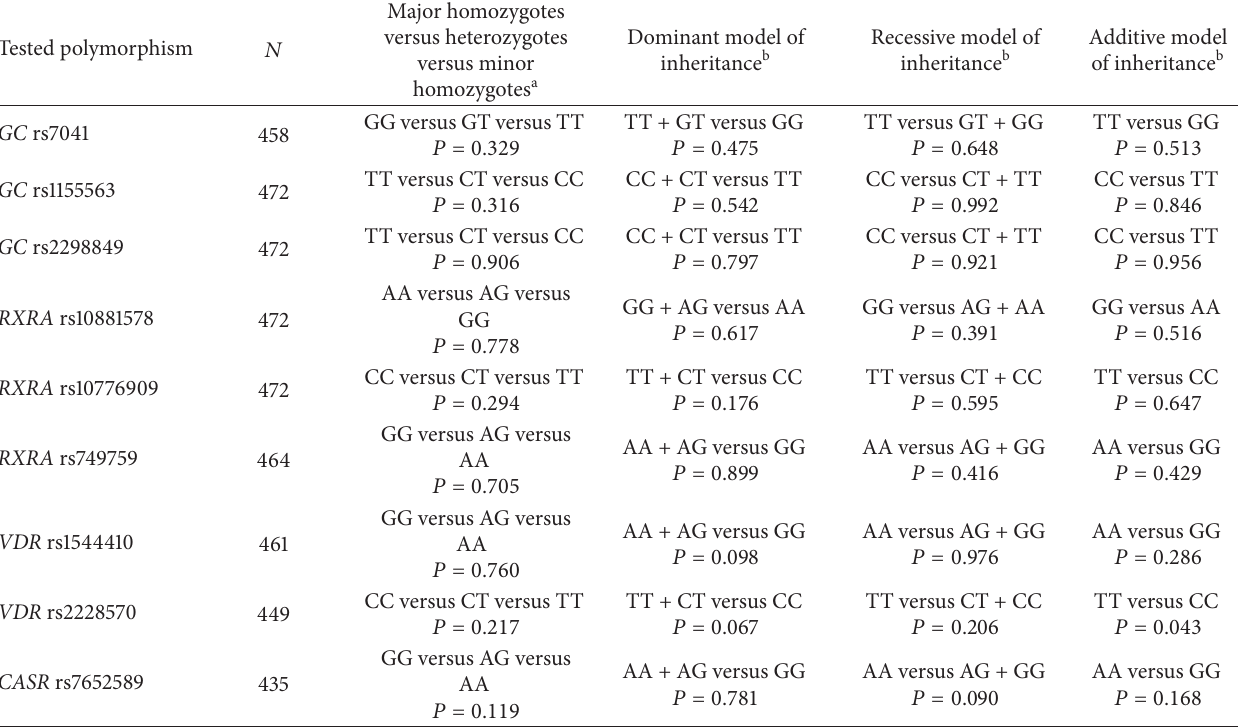
Table 4: Statistical significance of differences in cardiovascular mortality evaluated by the Kaplan-Meier analysis for vitamin D signaling pathway genes and CASR in hemodialysis patients undergoing the 7-year prospective study.